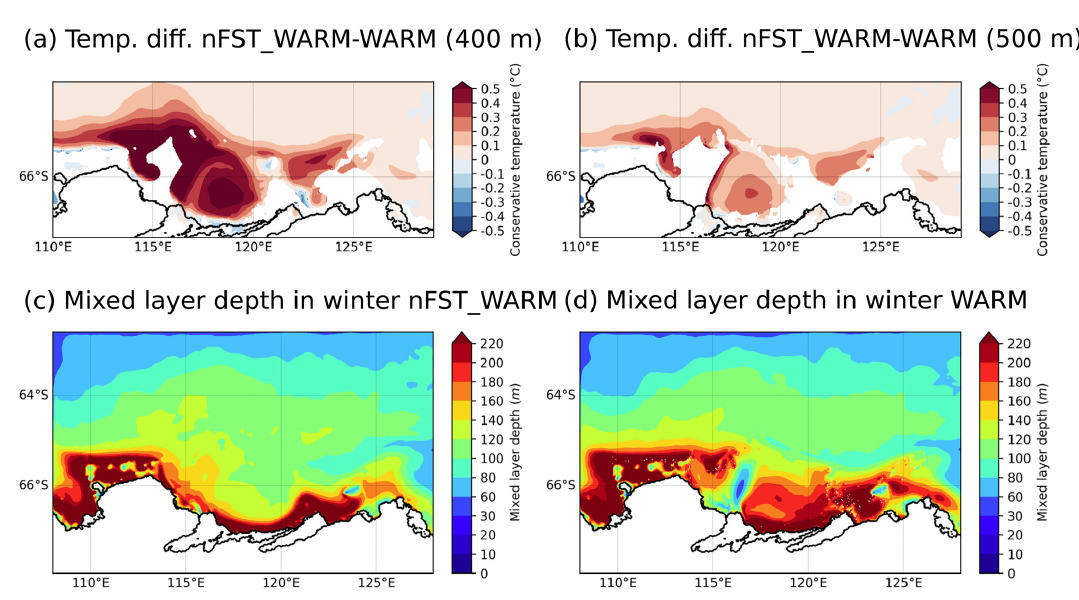
Figure 14. Annual mean ocean temperature differences between the nFST_WARM and WARM simulations over the continental shelf at 400 (a) and 500m depths (b) . Annual mean MLD for nFST_WARM (c) and WARM (d) for the winter months (JASO). Both the temperature anomalies and the MLD are averaged over the 20-year